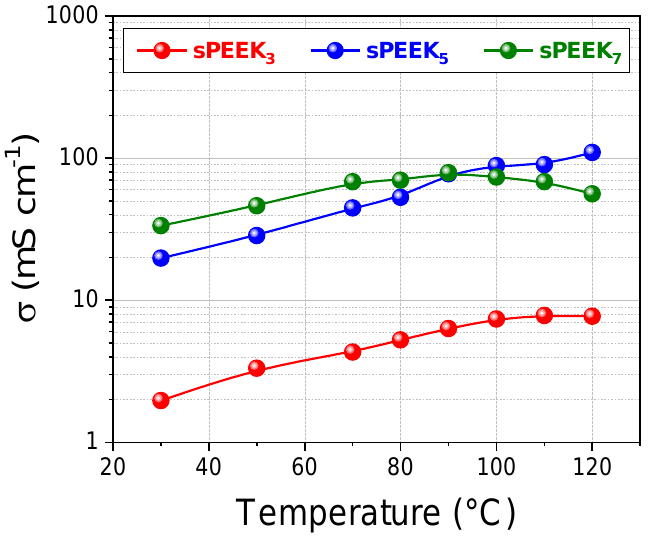
Figure 5. Proton conductivity of the sPEEK membranes at 90% RH.